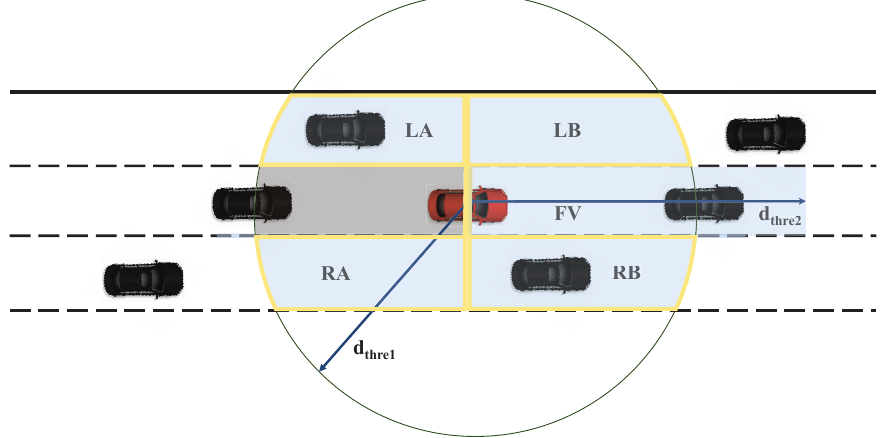
Figure 3. The attention area is divided into five sections by the distance